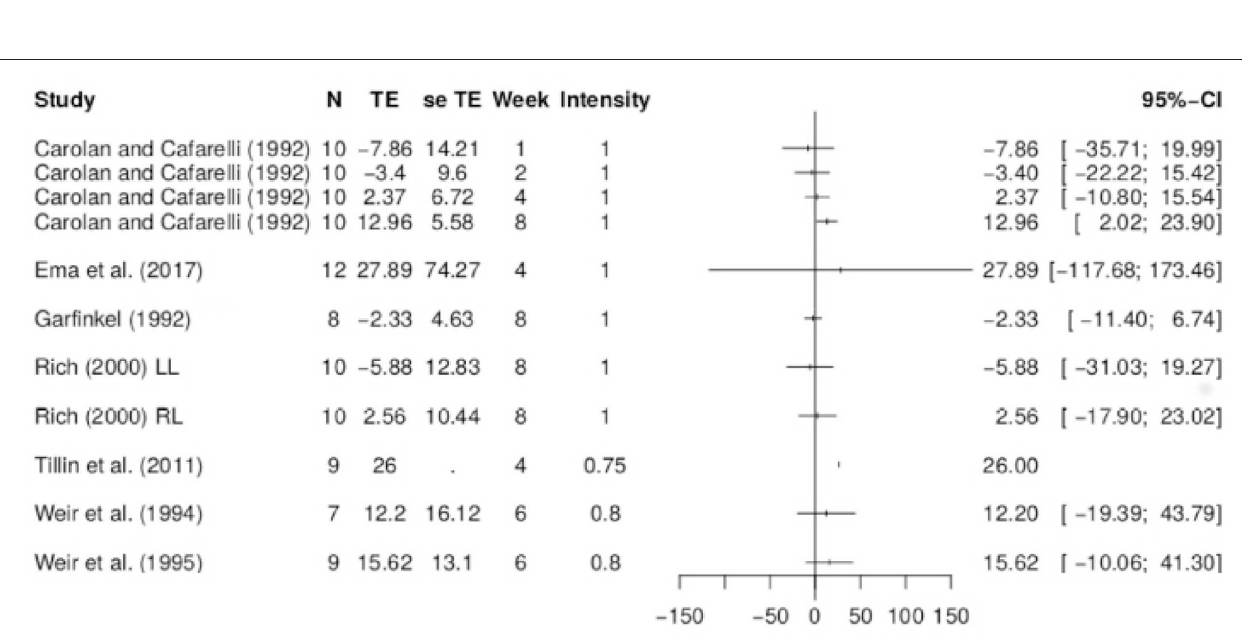
Frontiers in Sports and Active Living |